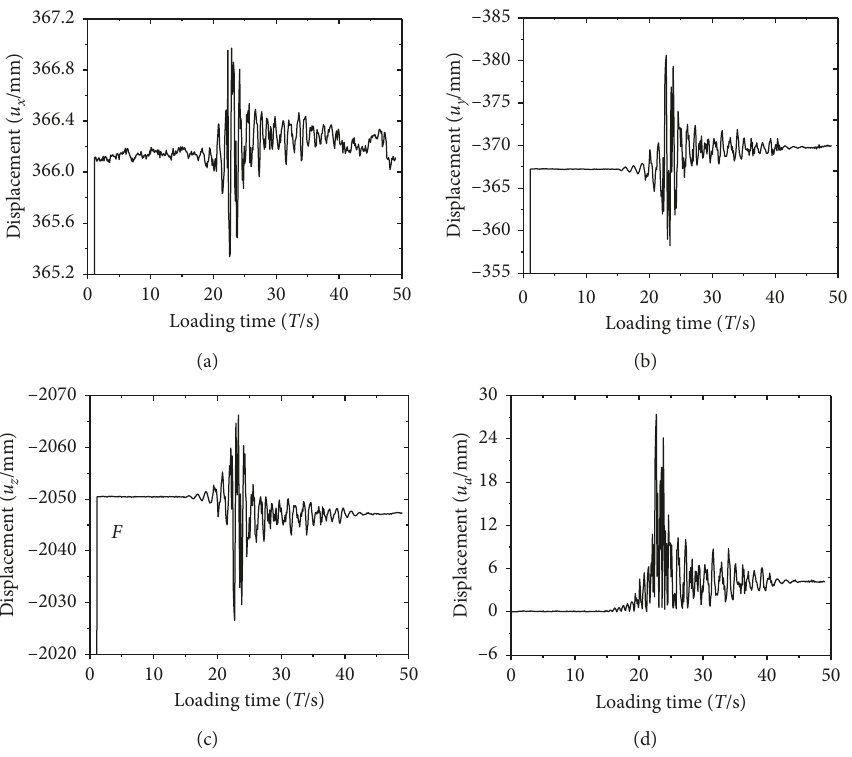
Figure 14: Variation of displacement with loading time.